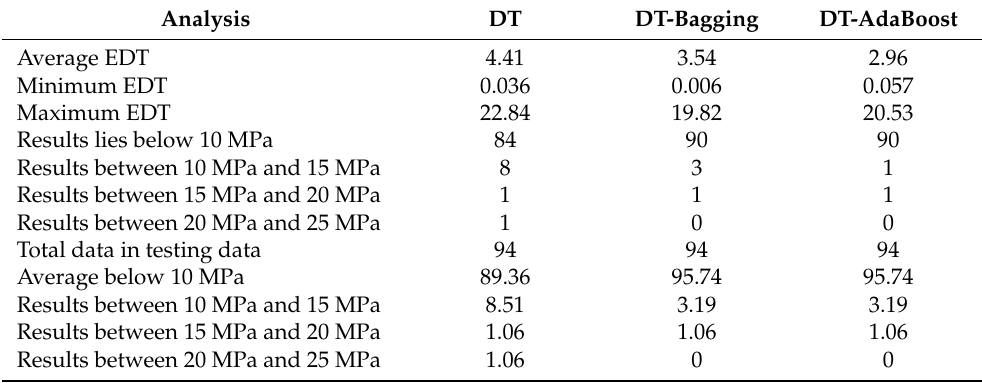
Figure 9. ( a ) DT prediction vs target; ( b ) DT error distribution; ( c ) actual vs prediction of DT-bagging; ( d ) DT-bagging error distribution; ( e ) actual vs forecasted results for DT-boosting; ( f ) error distribution of DT-boosting. Table 6. Statistical evaluation of an individual with ensemble DT